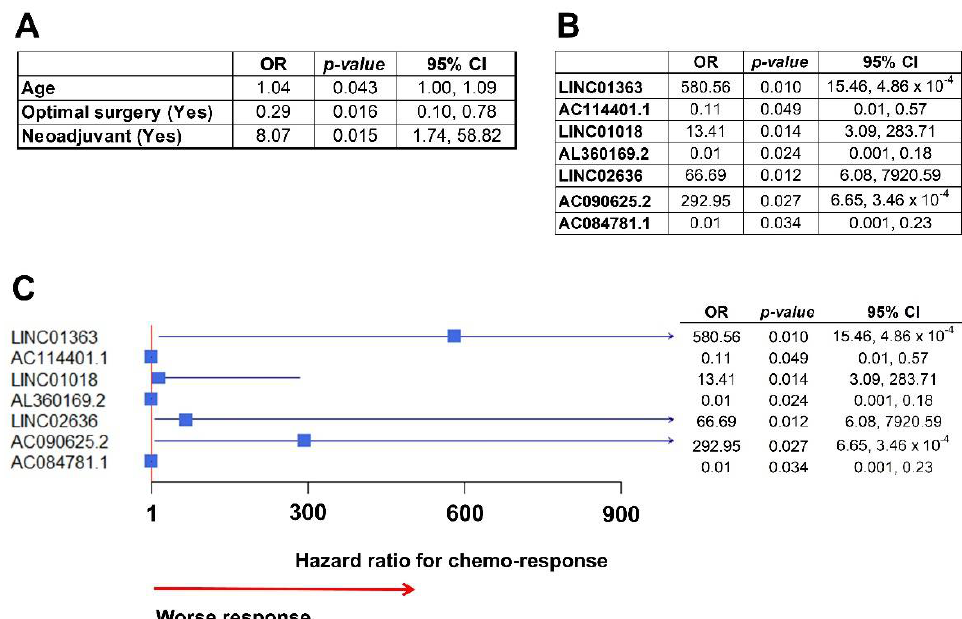
Figure 5. Association of lncRNA with chemo-response. ( A ) Table with clinical variables associated with chemo-response in the multivariate analysis. Patients that received neoadjuvant chemotherapy before surgery had an increased risk of not responding to initial chemotherapy (HR: 8.07), based on the definition described in Methods. ( B ) Table with lncRNA independently associated with chemo-response after the multivariate analysis. ( C ) Forest plot of the integrative multivariate model with clinical data and lncRNA expressions. All clinical variables dropped from the model and only lncRNAs remained. Notably, there were three lncRNAs highly associated with response to chemotherapy (worse response): LINC01363, with a HR over 580; LINC02636, with a HR over 66; and, ACO90625.2, with a HR over 292.